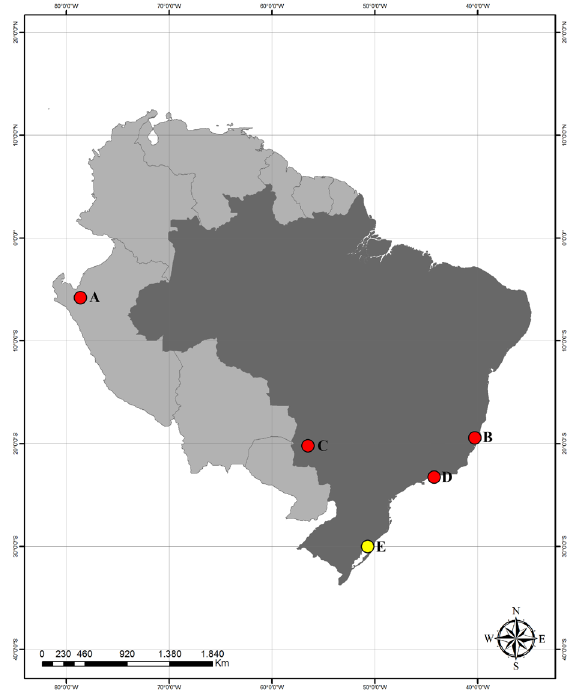
Figure 2. Map showing known geographic distribution (A–D) and the new record (E) of Diplotriaena delirae Pinto & Noronha, 1970. A. Province of Jaén, Peru. B. Linhares, state of Espírito Santo, Brazil. C. Salobra, state of Mato Grosso do Sul, Brazil. D. Angra dos Reis, state of Rio de Janeiro, Brazil. E. Capivari do Sul, state of Rio Grande do Sul,